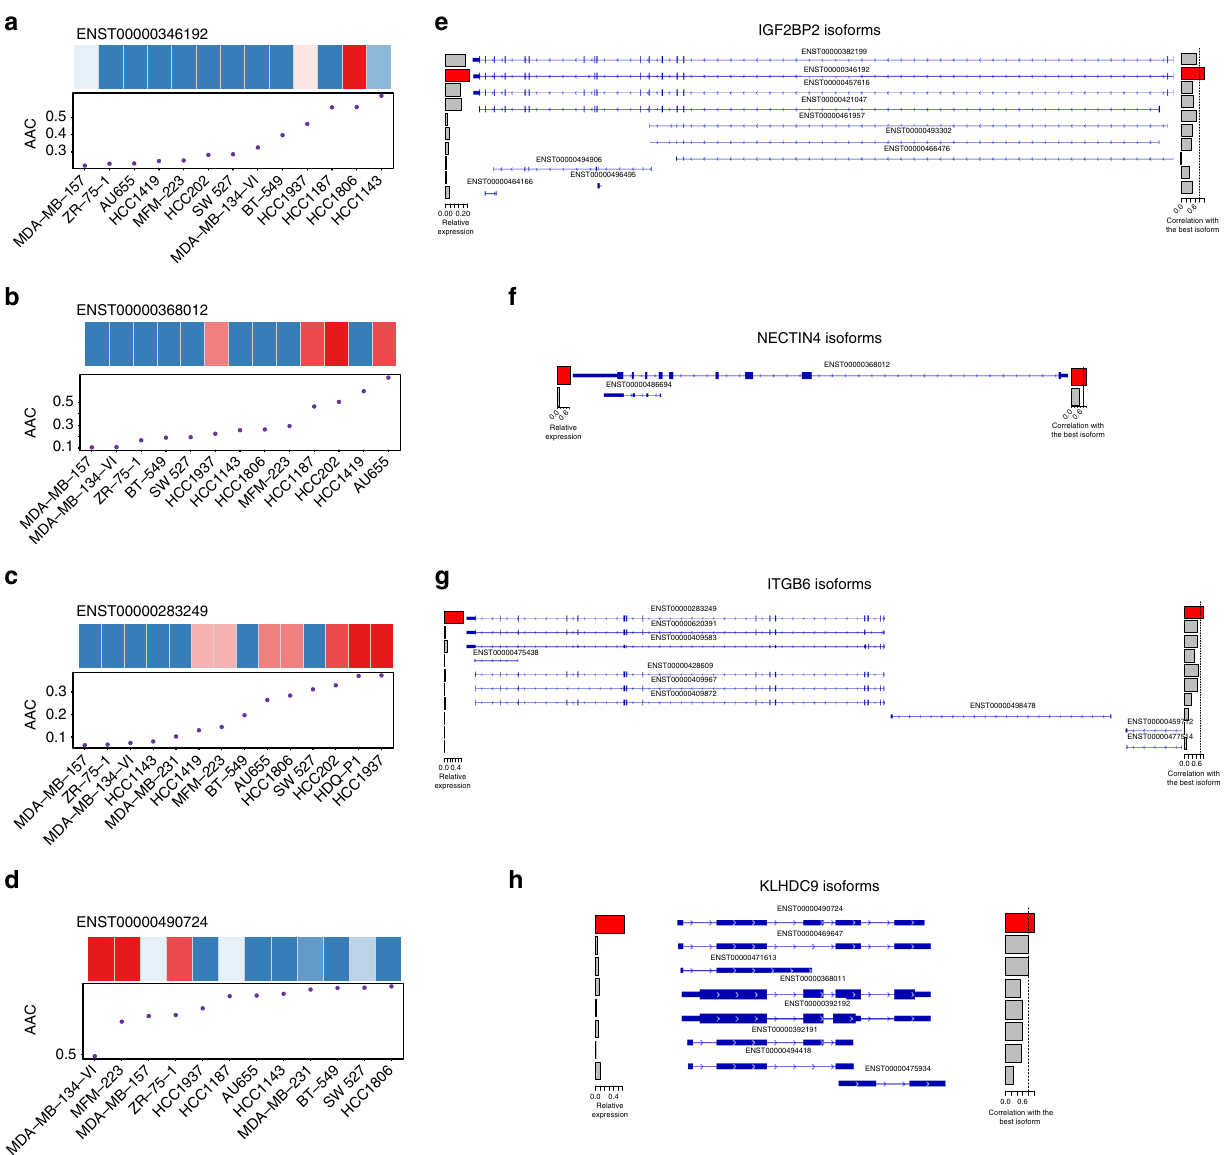
Fig. 6 Validation of the candidate isoforms predictive of response to a , e AZD6244; b , f lapatinib; c , g erlotinib, and d , h paclitaxel in the independent UHN dataset generated where a different pharmacological assay (sulforhodamine B assay) was used to measure drug sensitivity. a – d Cell lines are ordered by their sensitivity to the drug of interest and their isoform expression is shown in the heatmap, with the drug sensitivity (AAC) plotted below. e – h Exon occupancy of each candidate isoform (*) is visualized using the Integrative Genomic Viewer, with a barplot on the right side representing the correlation ( ρ ) of expression between each isoform and the candidate isoform (red bar). A vertical dashed line represents ρ = 0.8 to identify highly correlated isoforms of the same